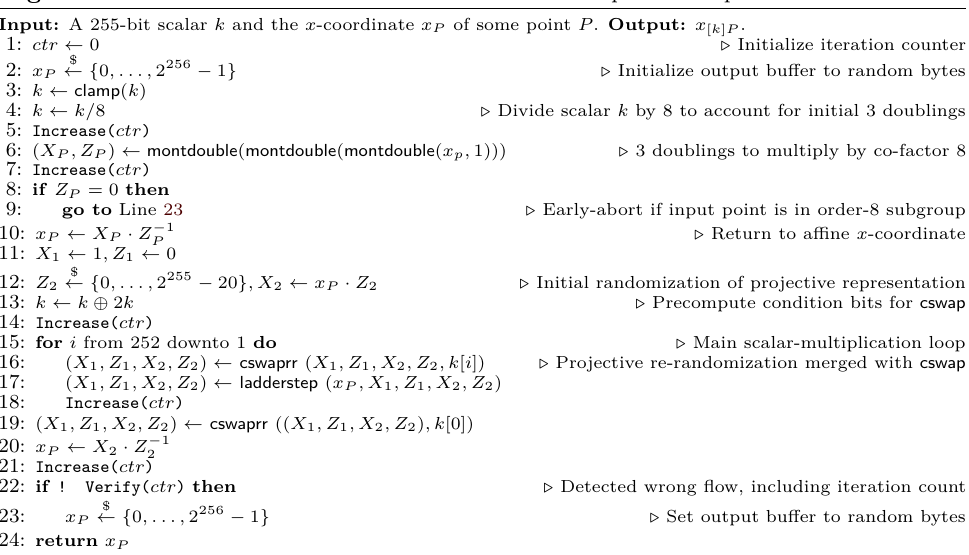
Algorithm 2 Pseudocode of side-channel and fault-attack protected ephemeral